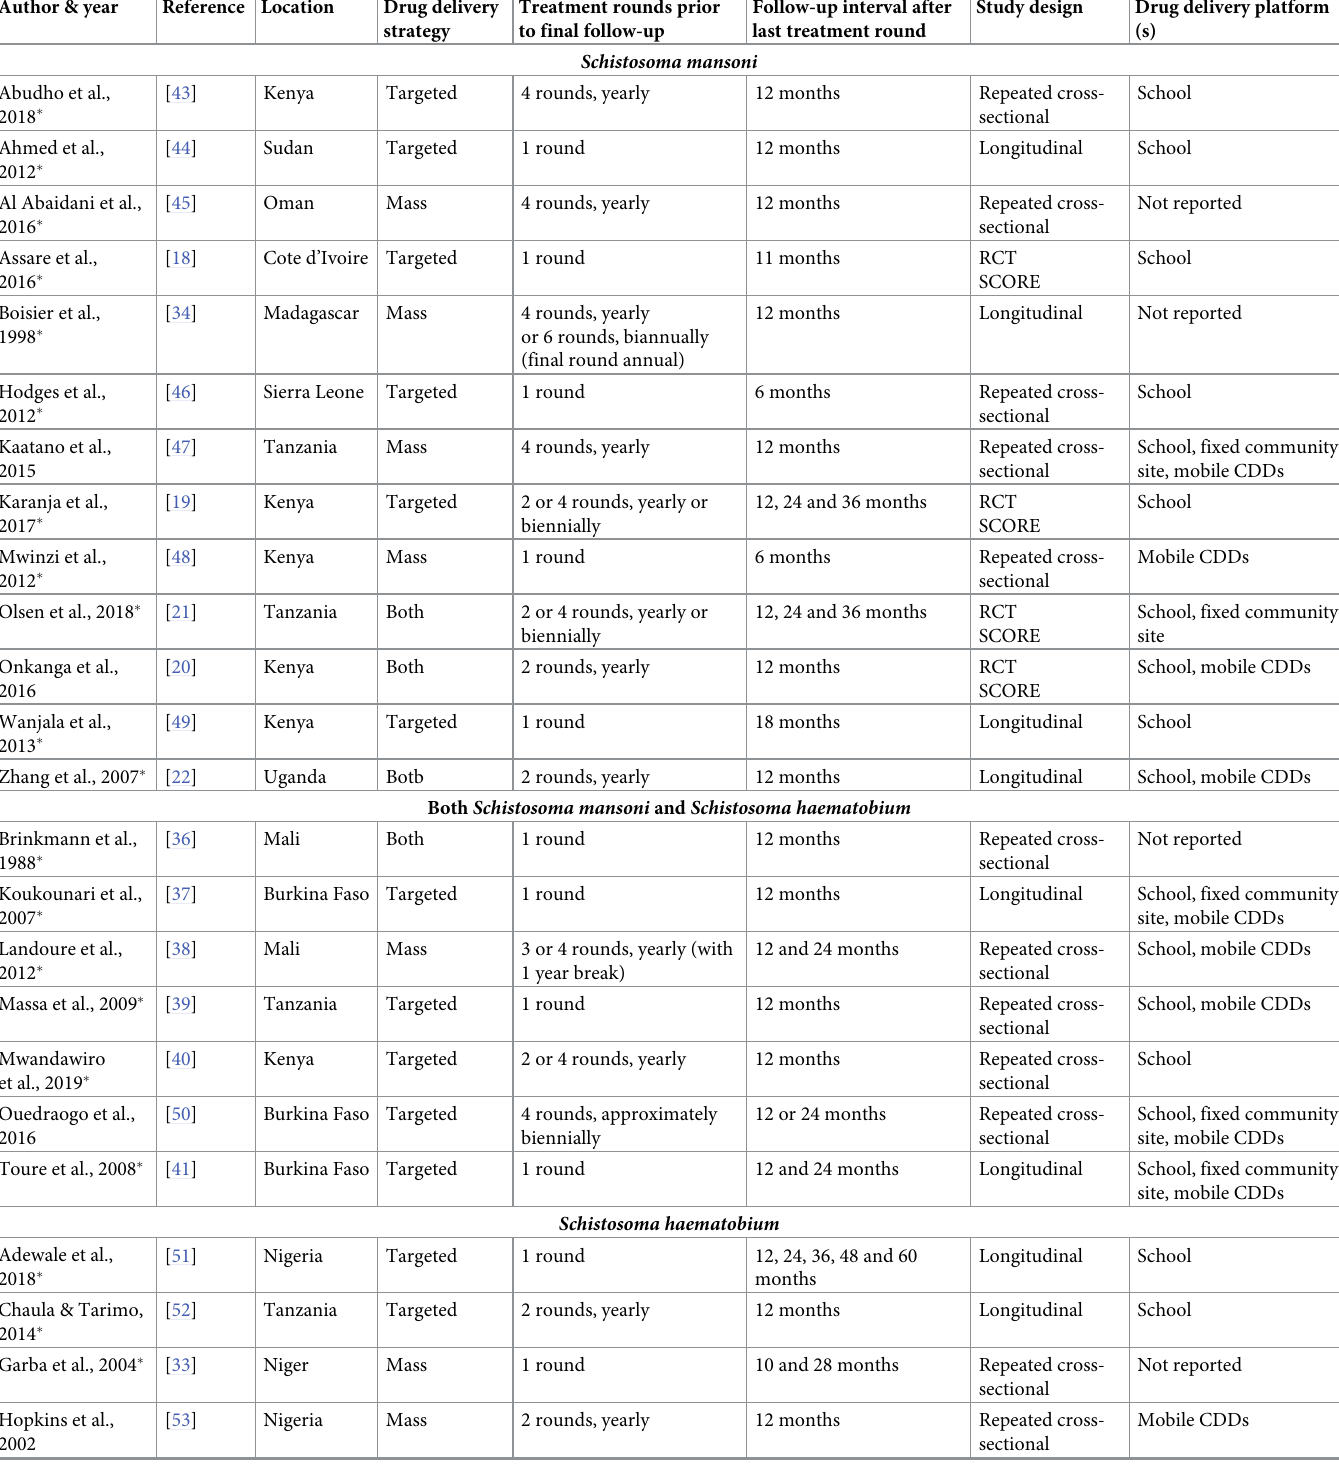
Table 1. Characteristics of included studies for systematic